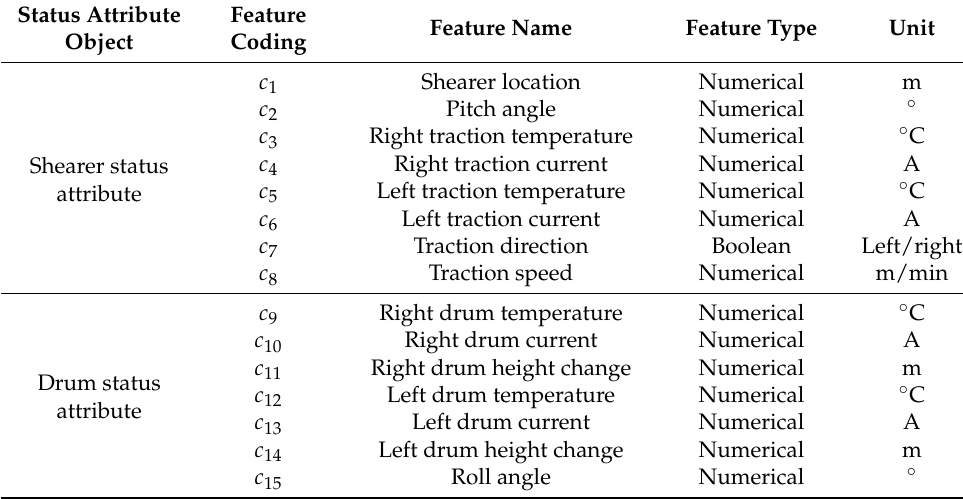
Table 1. Initial feature parameters.